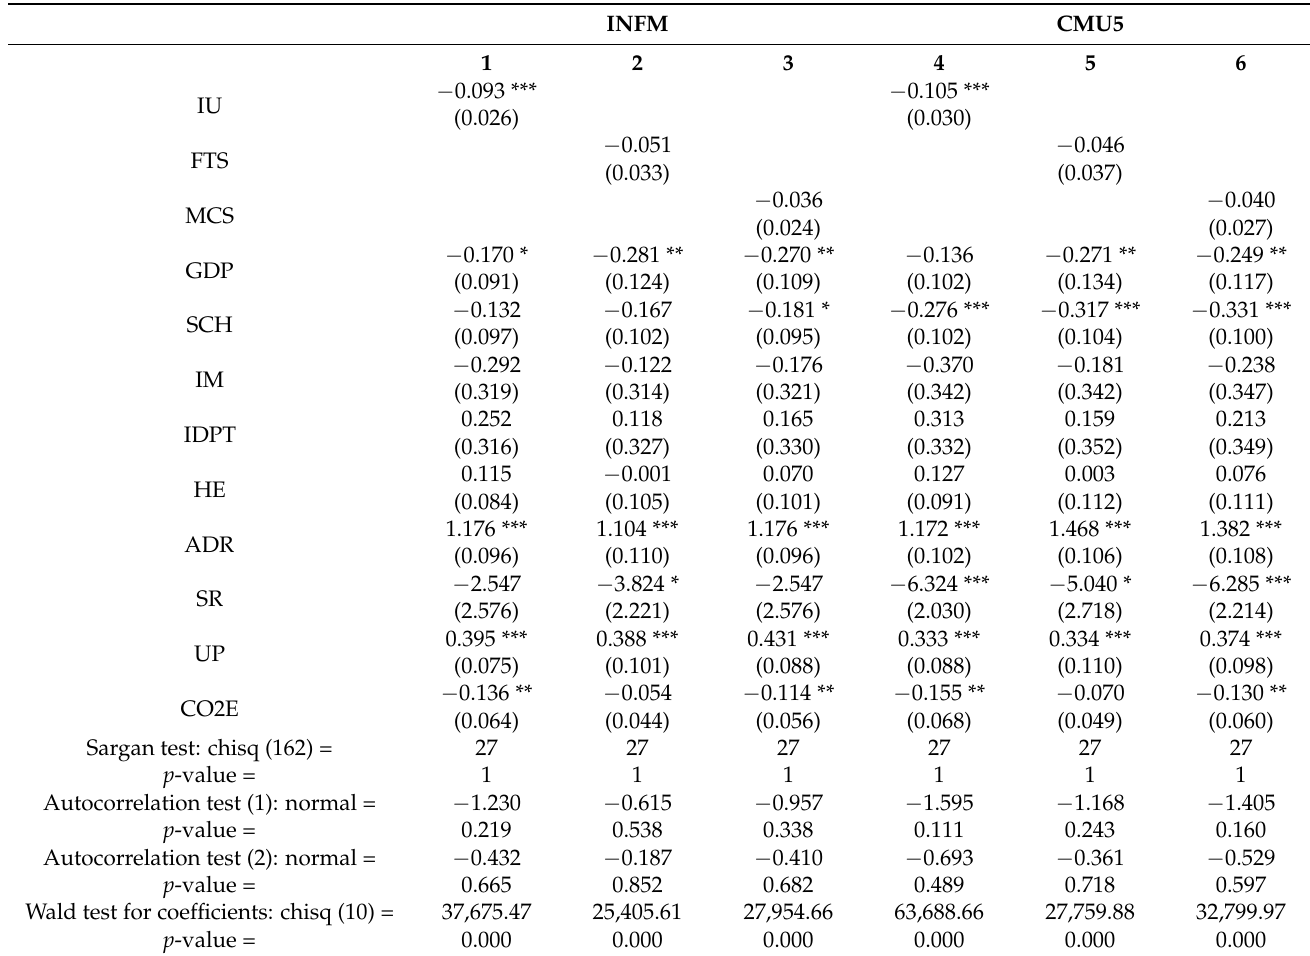
Table 6. System-GMM estimation results for infant mortality and child mortality under